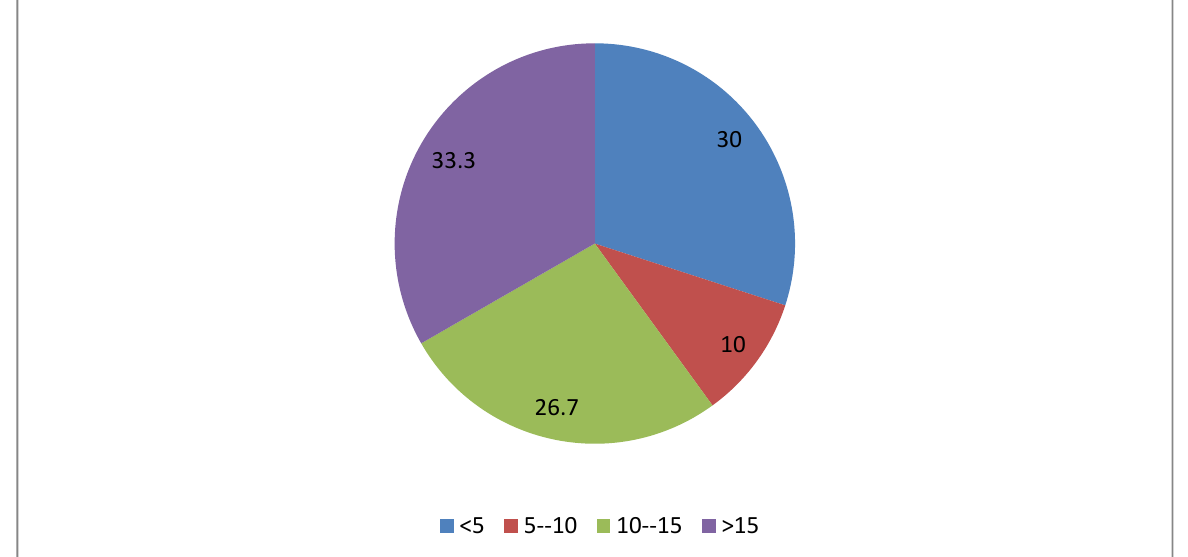
Fig. 2. The percentage of job experience